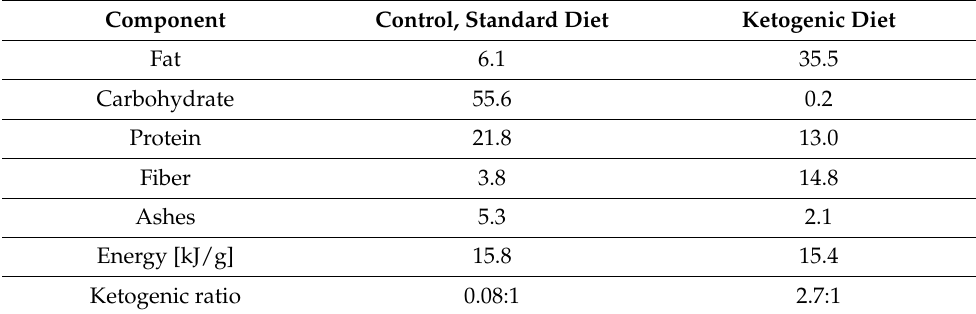
Table 2. Composition of the standard and ketogenic diets